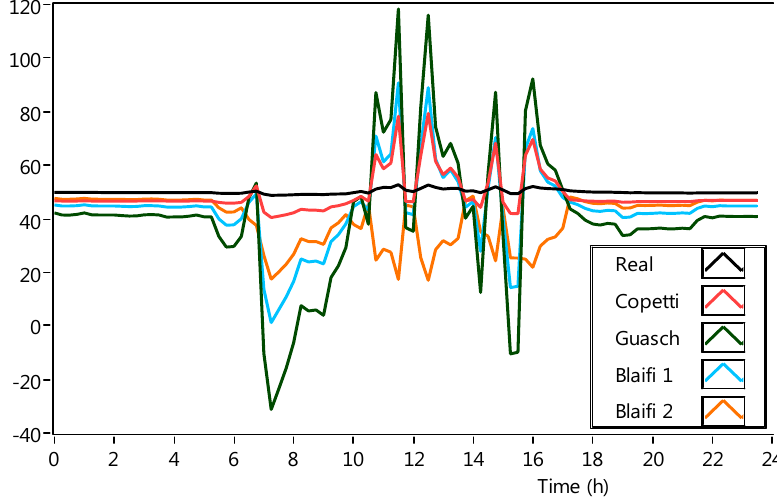
Figure 3. Model test using the parameters published in Table 1.